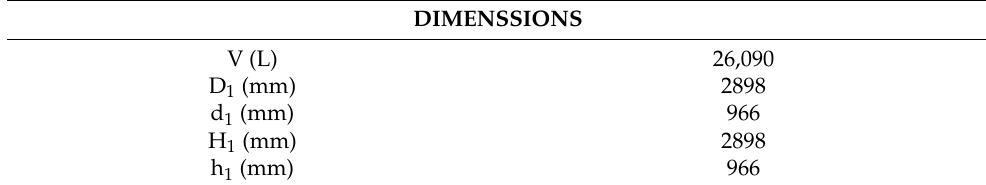
Table 7. Shape factors of the industrial scale